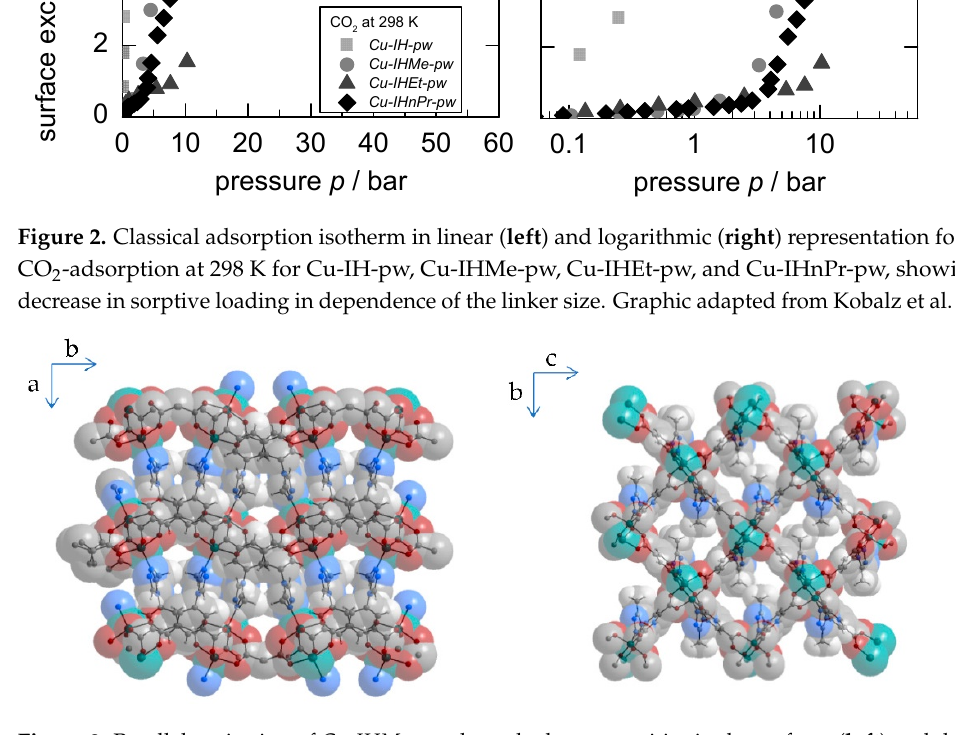
Figure 3. Parallel projection of Cu-IHMe-pw along the largest cavities in the np form ( left ) and the mp form ( right ), atoms shown with van der Waals radii.